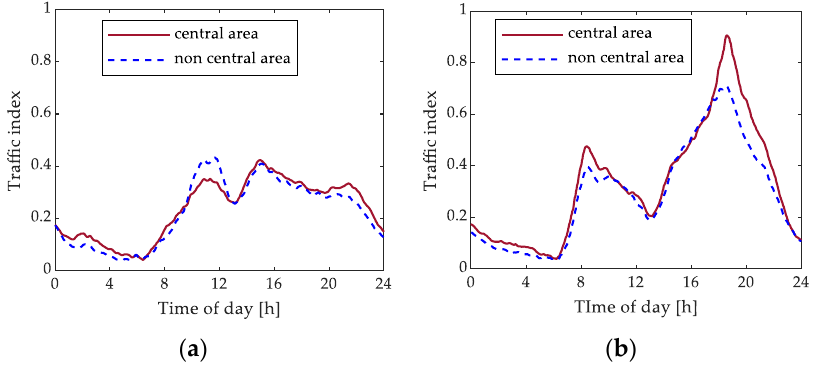
Figure 7. Traffic index of ( a ) weekend; ( b ) weekday. Figure 7. Tra ffi c index of ( a ) weekend; ( b ) weekday.